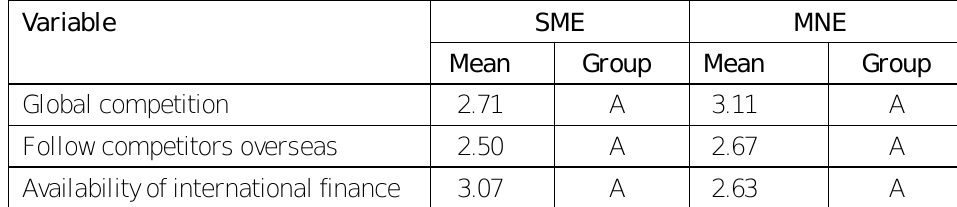
Table 4: Global factors descending means and sub-groups for SMEs and MNEs Variable Global competition Follow competitors